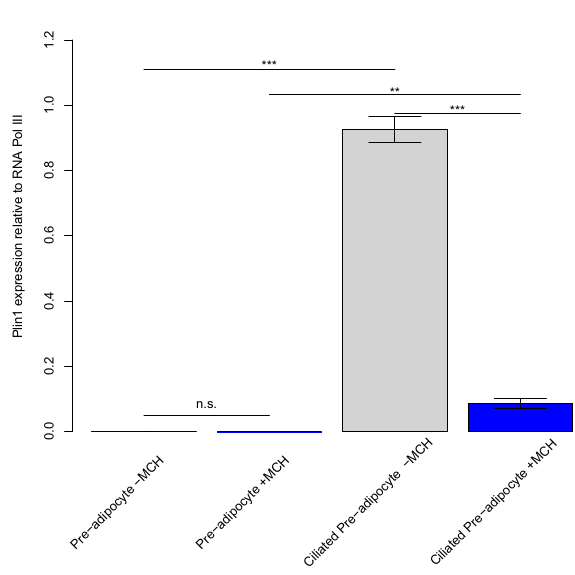
Figure 8. Expression of plin1 normalized to reference gene, analyzed by qPCR. Gene expression is markedly increased in ciliated cells compared to non-ciliated cells regardless of MCH treatment. However, in ciliated cells, this increase in expression is significantly attenuated with 100 nM MCH treatment for 6 h. * p < 0.05; ** p < 0.01; *** p < 0.001; n.s. not significant; n =